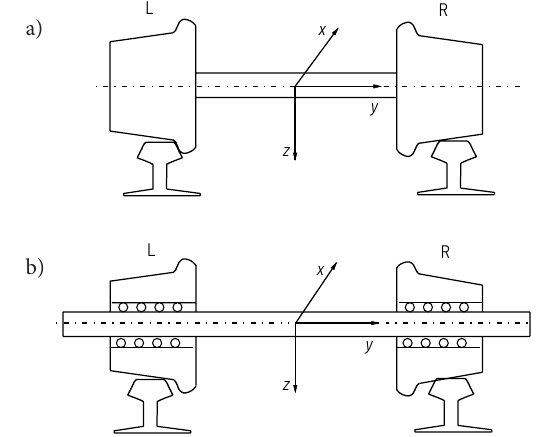
Fig. 1. The schematic diagram of the rigid wheelset and the independent rotation wheels: a – rigid wheelset; b – independent rotation